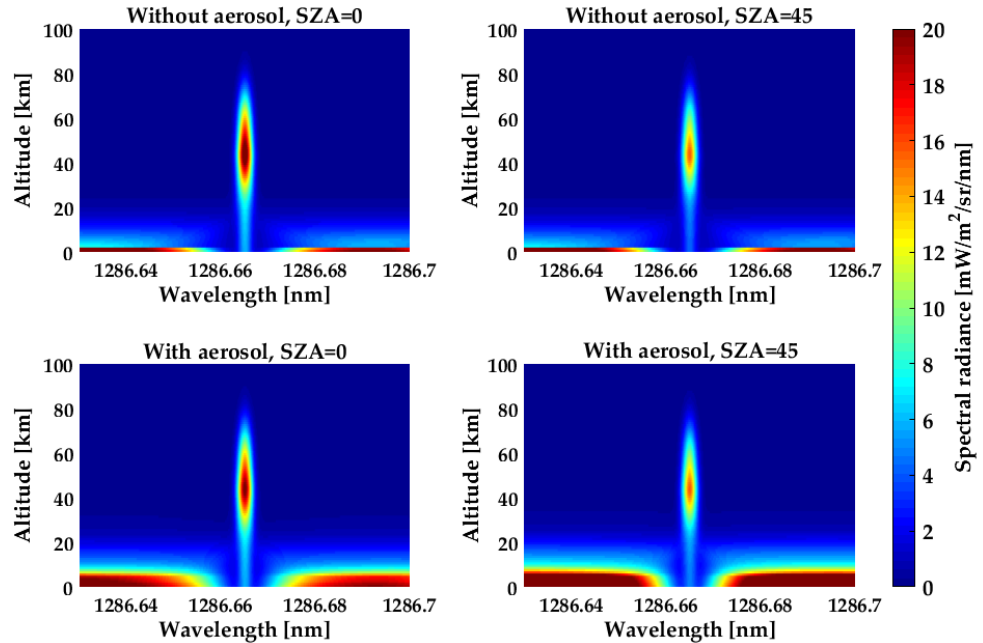
Figure 15. The variations in total spectral brightness with the solar zenith angle (SZA) and atmospheric aerosol at the tangent heights from 0 to 100 km.